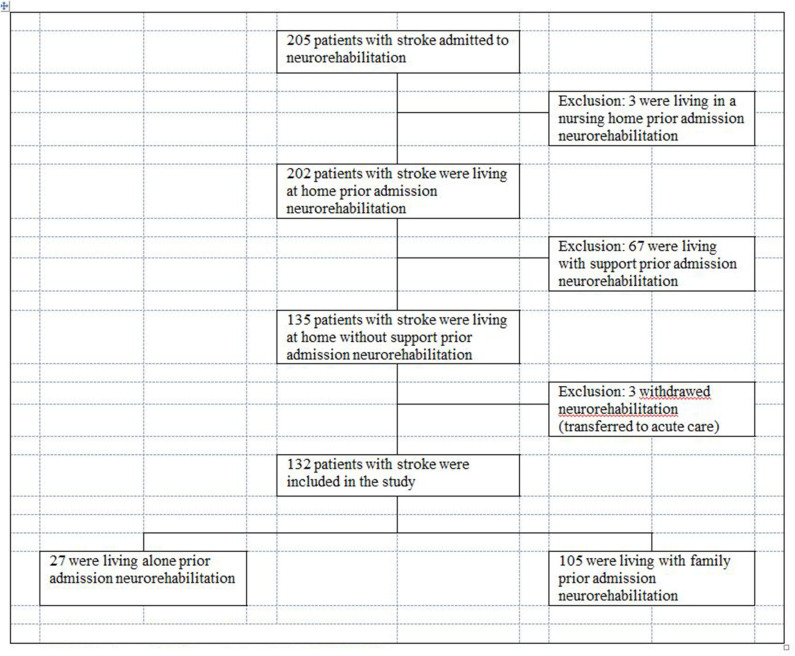
Flow chart—patient sample validation.